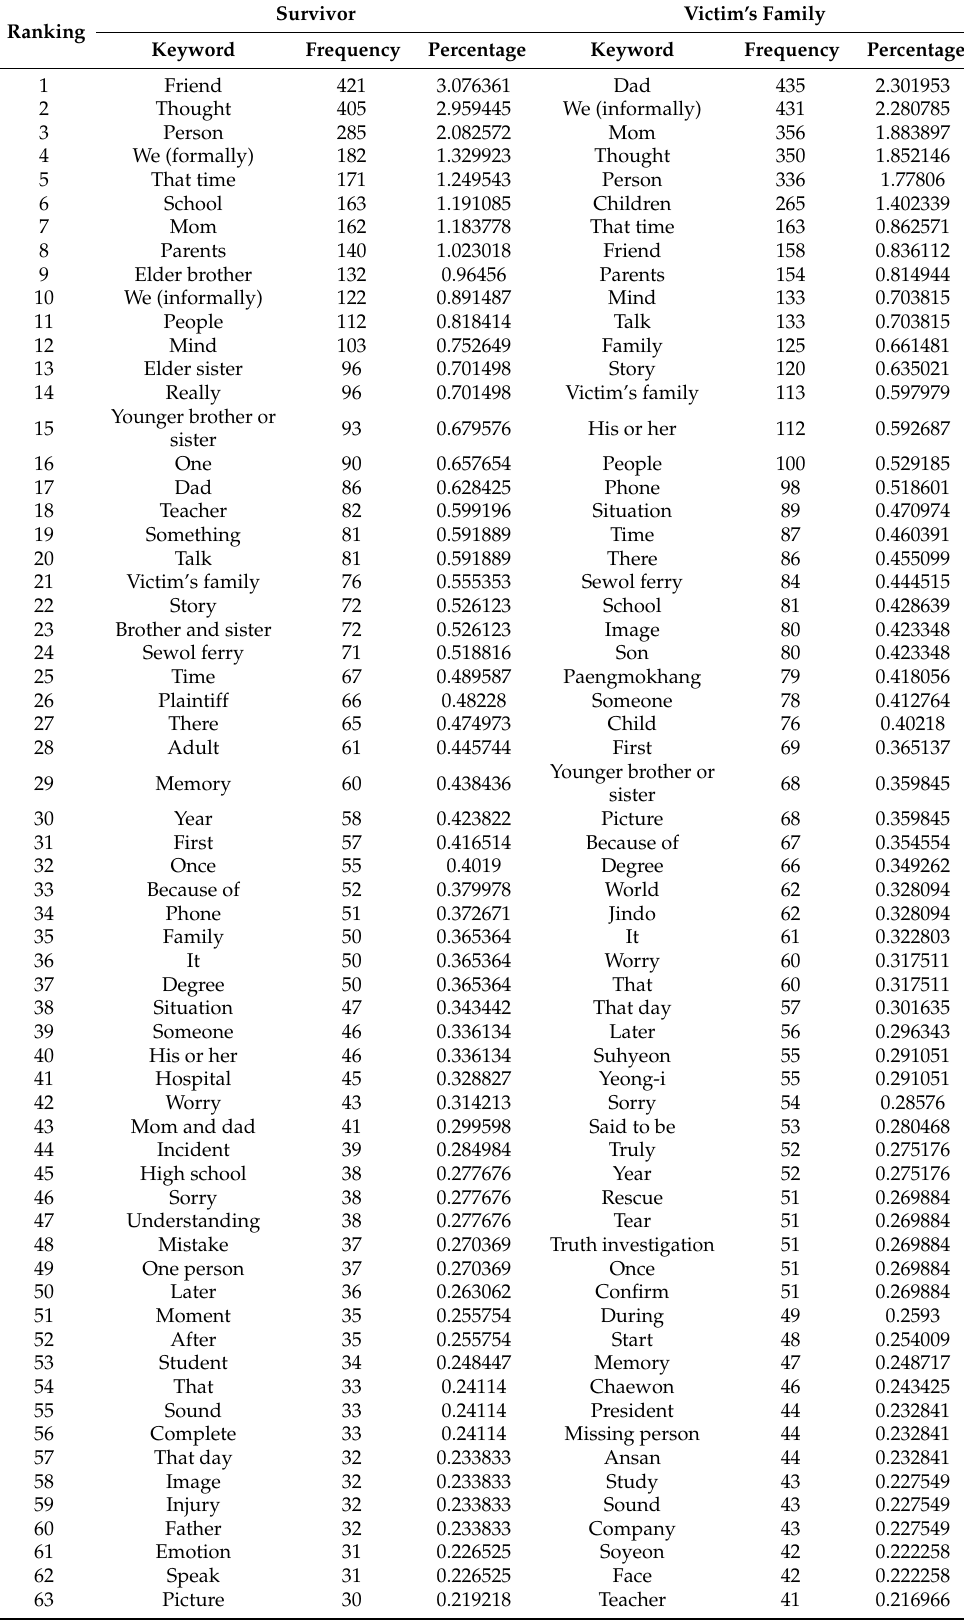
Table 1. Top 100 words in